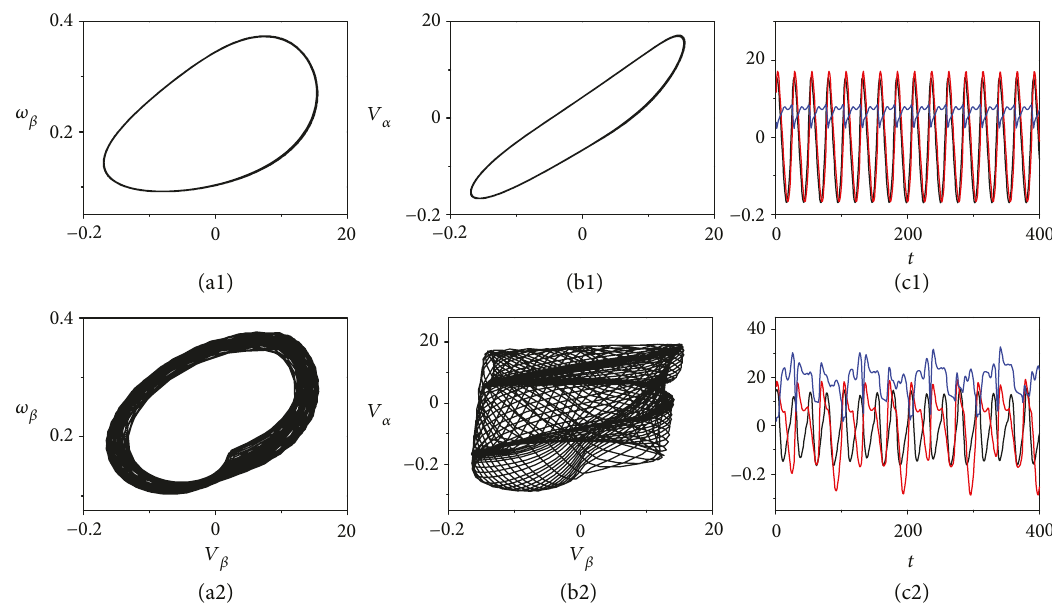
Figure 8: Numerical simulation of the two neuron system. The parameters are chosen as C = 0 5 and τ = 50 ms. (a1) The phase portrait of ( V β , ω β ), H syn = 0 03 . (a2) The phase portrait of ( V β , V α ), H syn = 0 03 . (a3) The time series of V β (black line), V α (red line), and e (blue line), H syn = 0 03 . (b1) The phase portrait of ( V β , ω β ), H =0.32. (b2) The phase portrait of ( V β , V α ), H syn = 0 32 . (b3) The time series of V β syn (black line), V α (red line), and e (blue line), H syn = 0 32 .